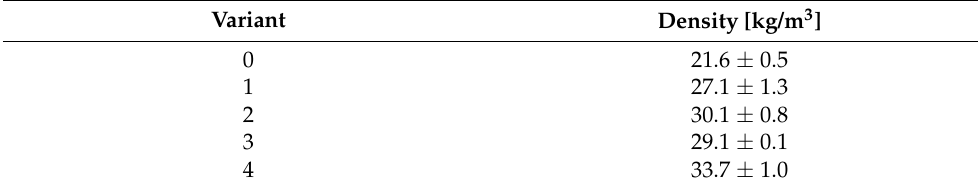
Table 2. Density of manufactured PUR-WP composites.